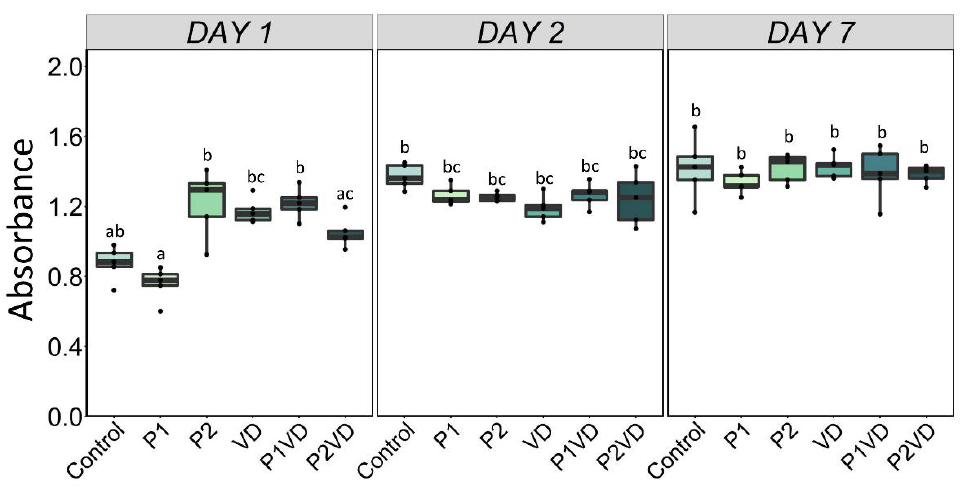
Figure 1. Cell viability analyzed by XTT assay in human fetal osteoblasts (hFOB1.19) exposed to different treatments — cultured without any treatment (Control), treated with VD (VD), with two probiotics (P1 and P2) and their respective combinations with VD (P1VD and P2VD). Two-way ANOVA was used to analyze the difference among the groups and Tukey’s post hoc test was used for multiple comparisons among every group. Data are shown as means ± SD as error bars. Different letters above each column denote statistically significant differences among all experimental groups after 1, 2, and 7 days ( n = 5, p < 0.05). Three groups that differ significantly from each other are labelled a, b, and c, and two that differ from each other but not from the third are labelled a, b, and ab.